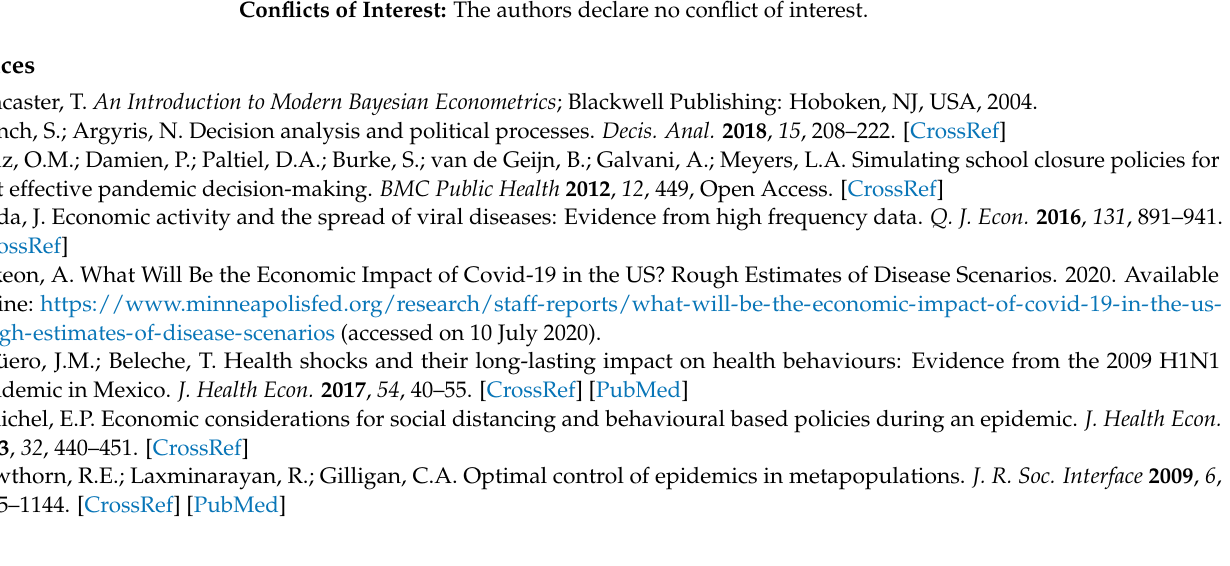
fatality rate model parameters; Figure S1: Trace plots of parameters of the Florida employment model; Figure S2: Histograms of parameters of the Florida employment model; Figure S3: Trace plots of parameters in the Florida fatality rate model; Figure S4: Histograms of parameters of the Florida fatality rate